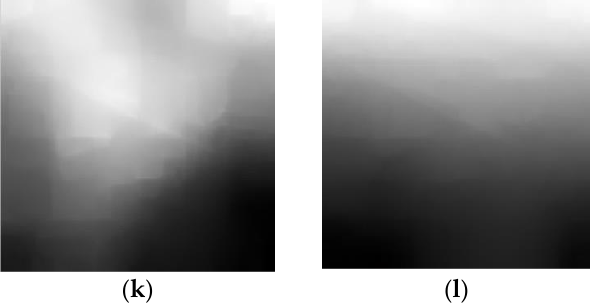
Figure 6. Curvature filter (CF) and domain transform recursive filter (DTRF) comparison for Indian Pines; ( a ) the 10th band of spectrum; ( b ) the 60th band of spectrum; ( c ) the 130th band of spectrum; ( d ) the 180th band of spectrum; ( e ) the 10th band filtering of CF; ( f ) the 60th band filtering of CF; ( g ) the 130th band filtering of CF; ( h ) the 180th band filtering of CF; ( i ) the 10th band filtering of DTRF; ( j ) the 60th band filtering of DTRF; ( k ) the 130th band filtering of DTRF; ( h ) the 180th band filtering of DTRF.